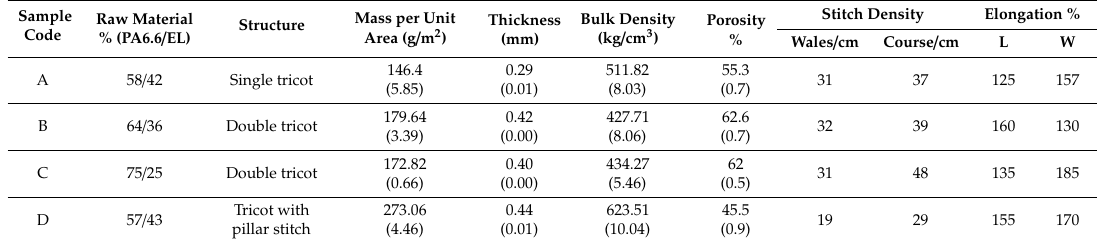
Table 1. Mean values (SD) for the structural parameters of fabrics